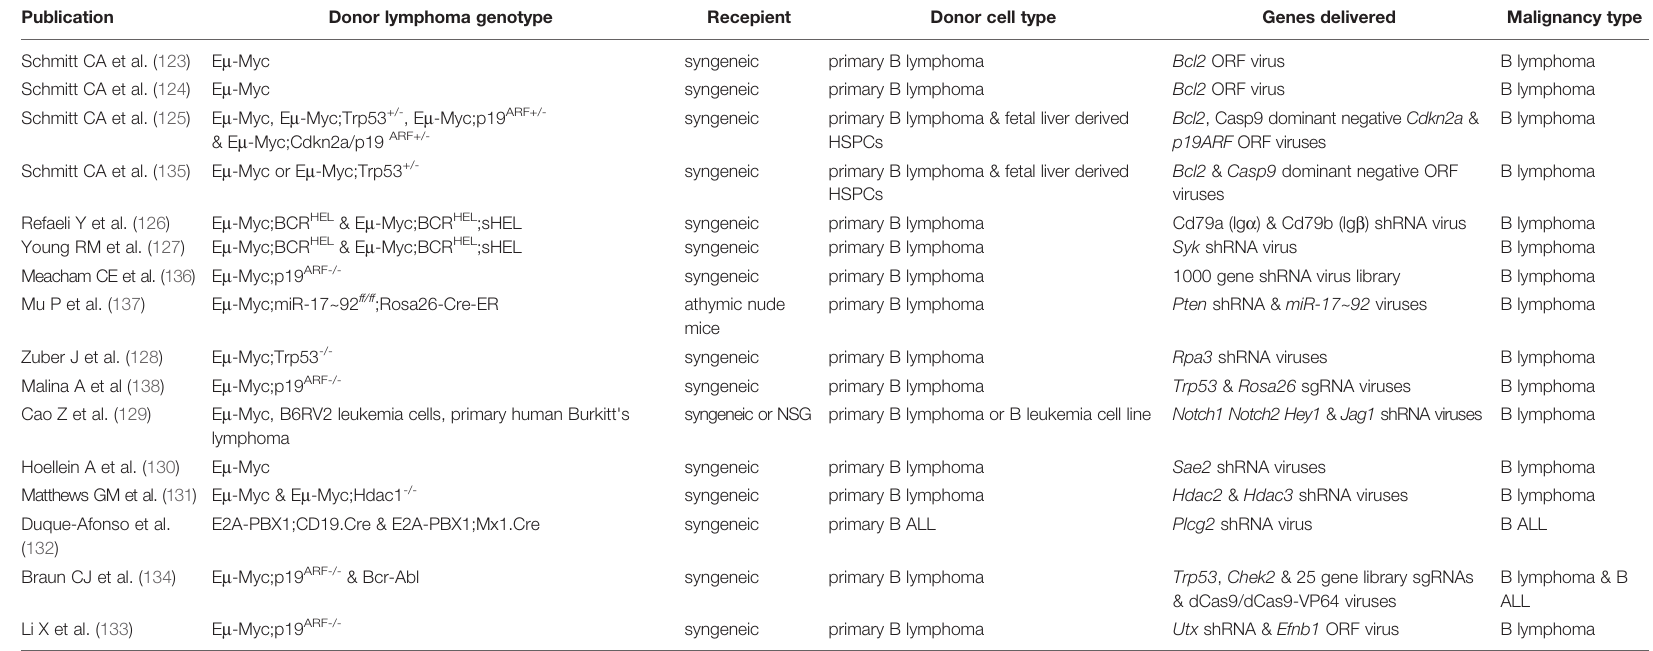
TABLE 3 | Reverse genetic B cell malignancy transplantation assays using primary